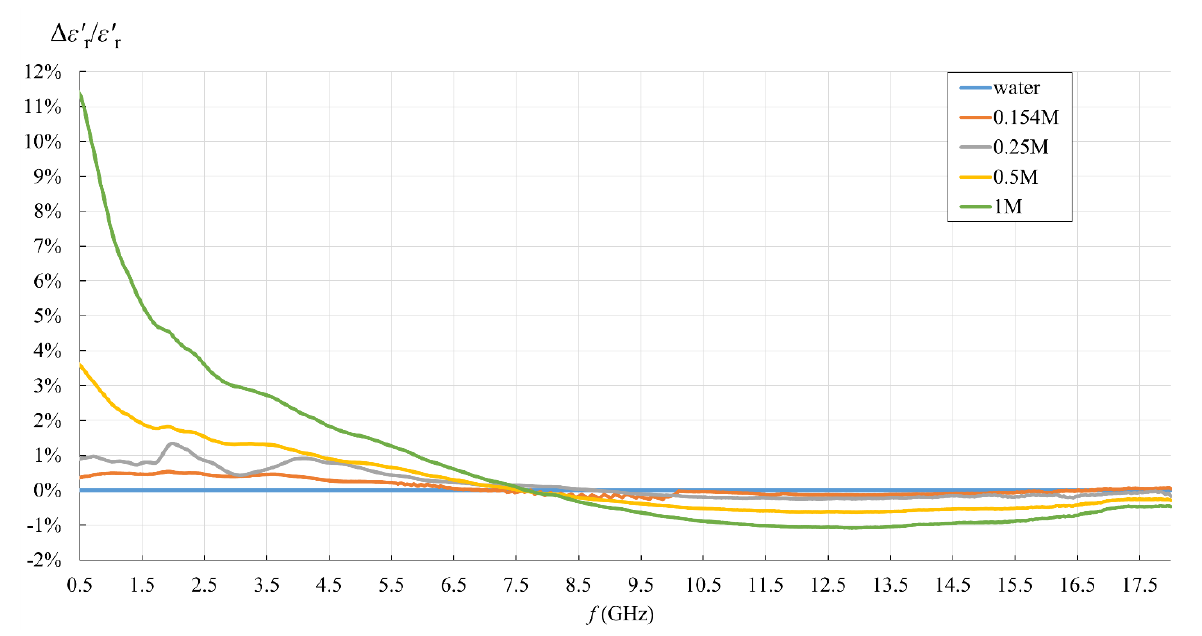
Figure 11. 𝜺 𝐫′ relative error of the simple capacitive-load model with respect to the measurement result obtained from the measurement software, for water and saline solutions with different NaCl concentrations.